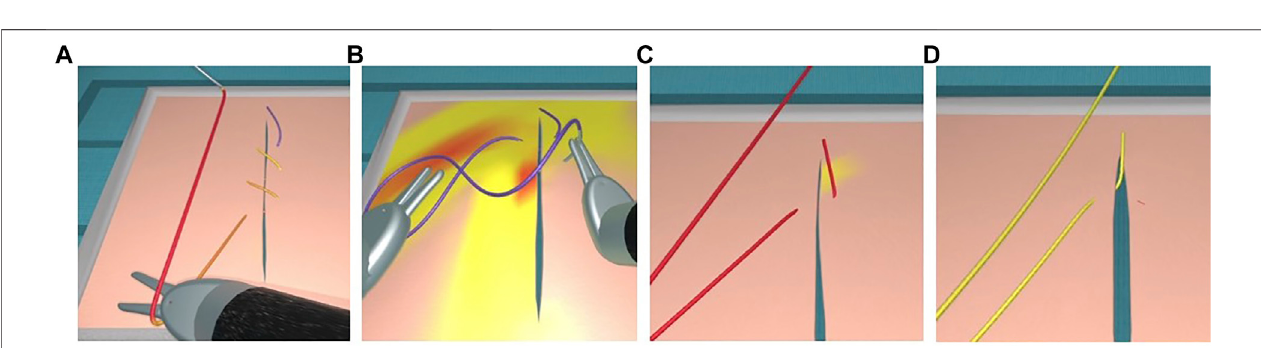
Frontiers in Robotics and AI |